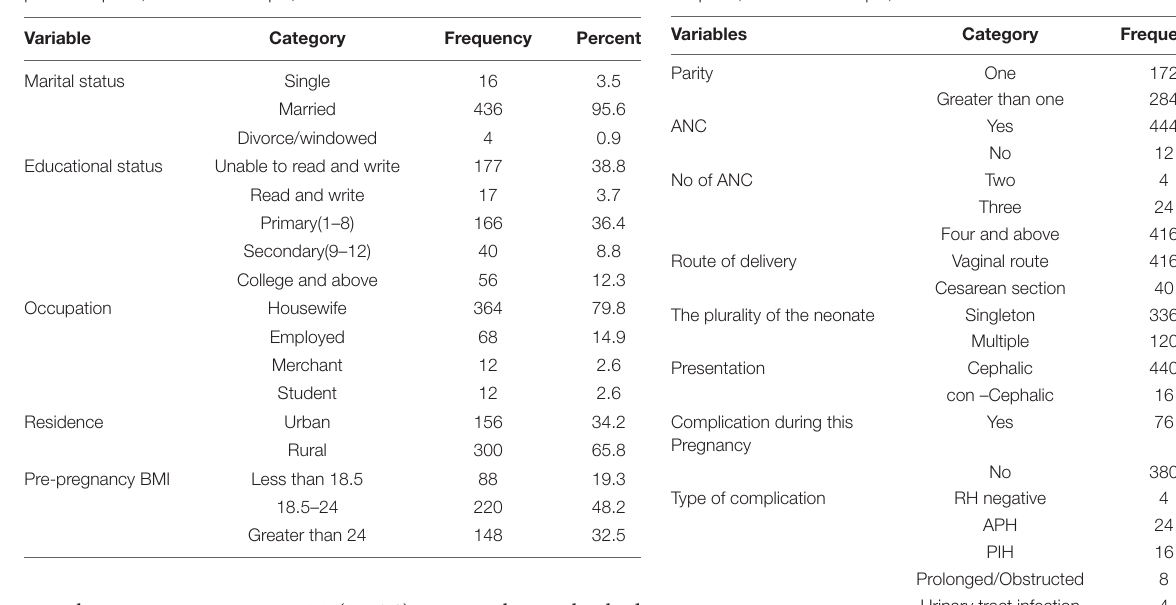
TABLE 2 | Maternal obstetric-related characteristics in south Gondar zone public hospitals, northwest Ethiopia,